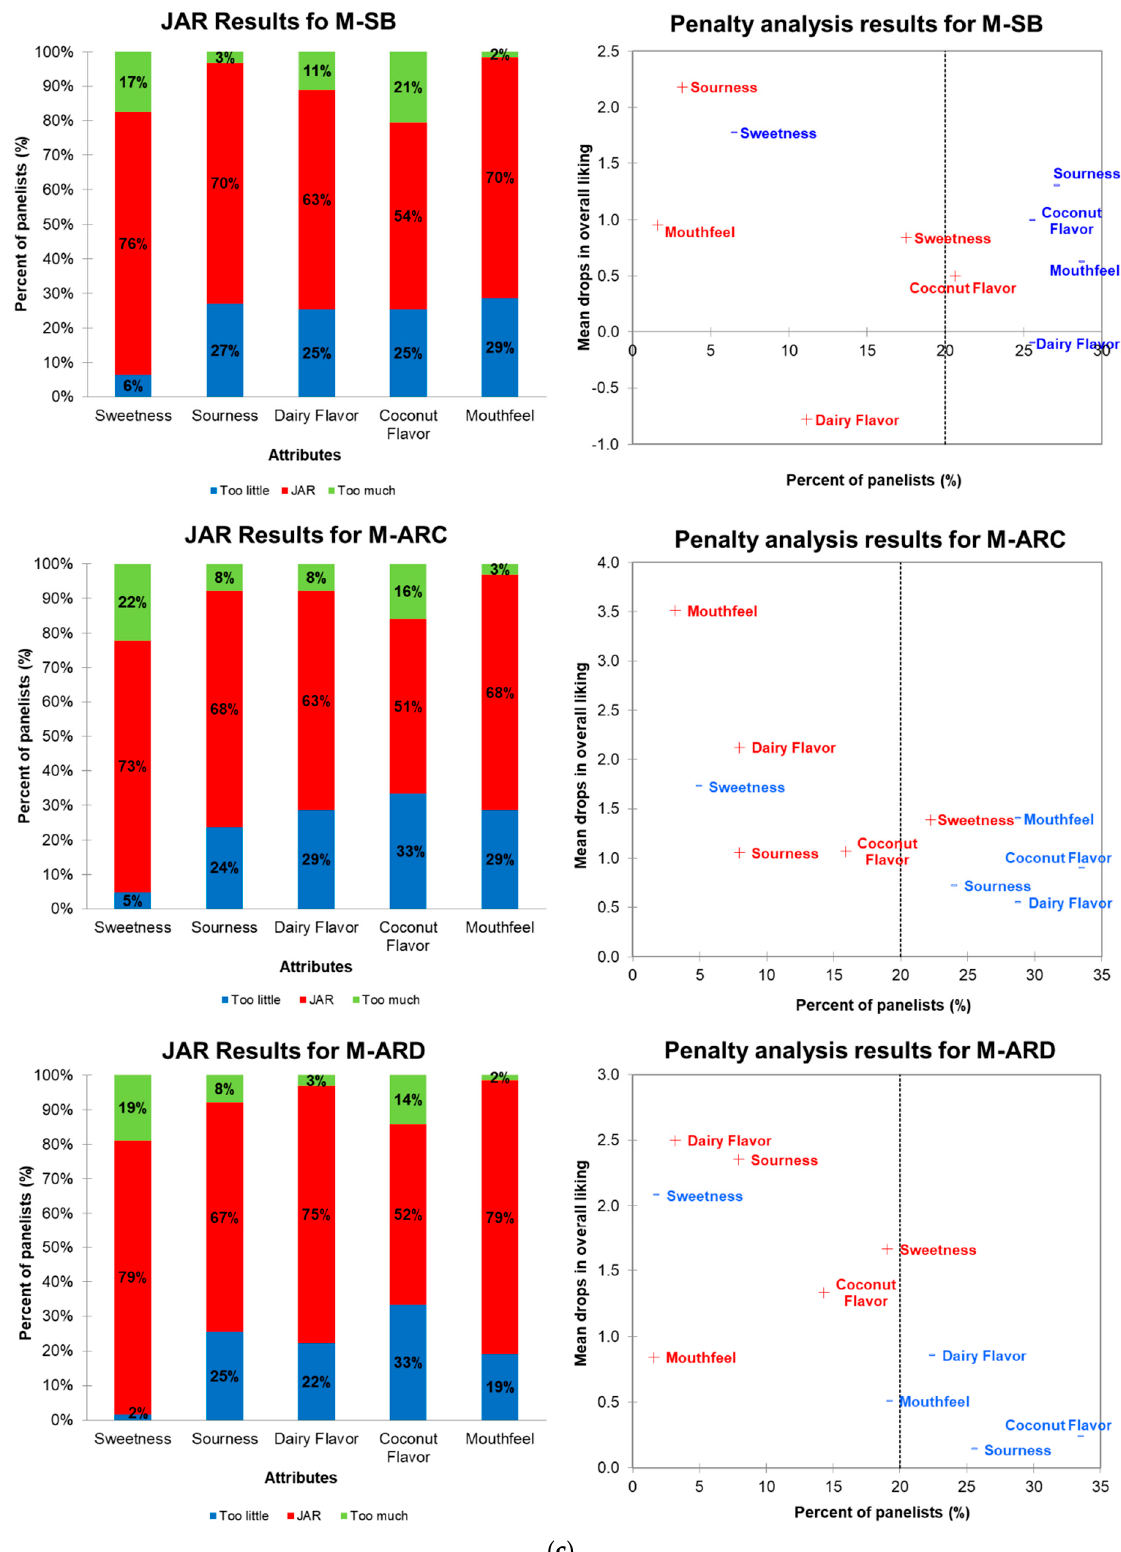
Figure 2. Just-about-right (JAR) frequencies and penalty analysis results of sensory attributes (-, too little; +, too much) of ( a ) coconut, ( b ) dairy, and ( c ) mixed yogurts under SB, AR1, and AR2. The description of the treatment’s labels can be found in the footnote of Table 2.